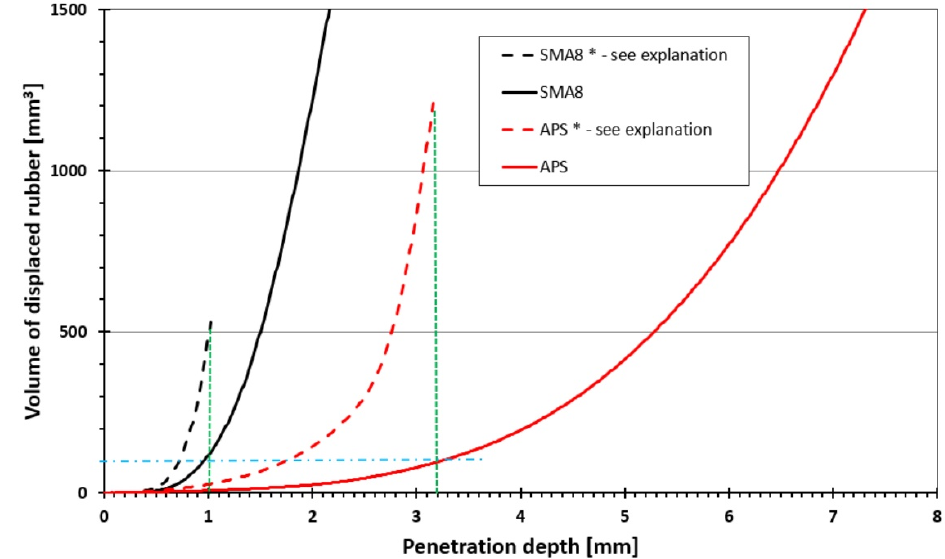
Figure 18. Relation between volume of deflected rubber and penetration depth for pavements SMA8 and APS. Solid lines show relations accounting only for geometrical shape of the texture while dashed lines account also for tread “bridges” deflection.